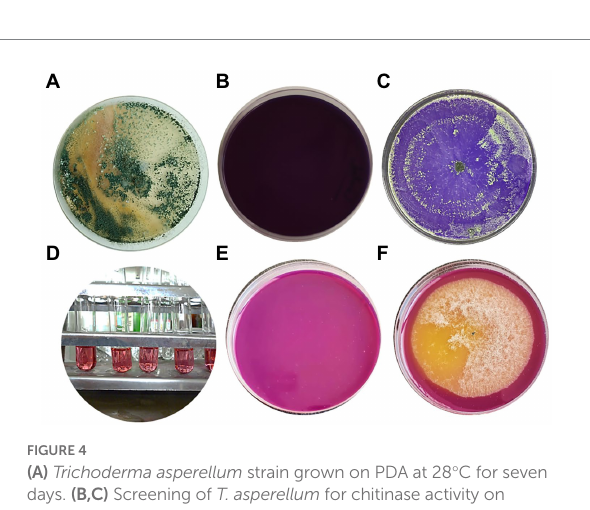
FIGURE 4 (A) Trichoderma asperellum strain grown on PDA at 28 ° C for seven days. (B,C) Screening of T. asperellum for chitinase activity on medium supplemented with colloidal chitin and control without inoculum. (D) IAA production by T. asperellum (5 replicates). (E,F) Phosphate solubilization of T. asperellum on NBRIP media supplemented with bromophenol blue as an indicator. (E) Uninoculated (control), (F) inoculated with T.